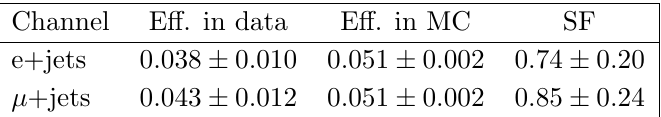
Table 1 . The mistag rates in data and simulation, and their ratio (data/simulation SF), for AK8 jets in the lepton+jets